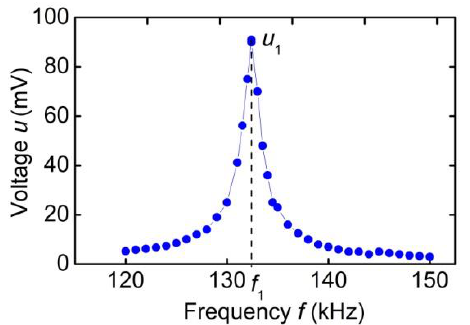
Figure 14. Dependence of ME voltage u on the frequency f of the excitation current for the Metglas/PZT/Metglas heterostructure, placed in a “magnetic capacitor”.